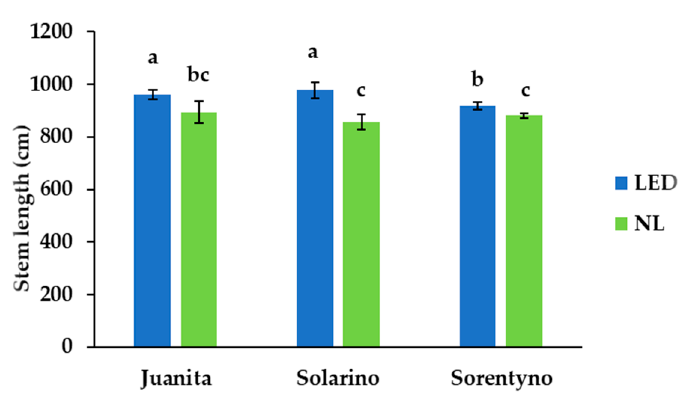
Figure 3. Stem length at the end of the growing cycle of three tomato cultivars grown with LED, used as supplemental light, and with natural light. Vertical bars indicate ± SE. The same lowercase letters indicate that the mean values are not significantly different ( p = 0.05).